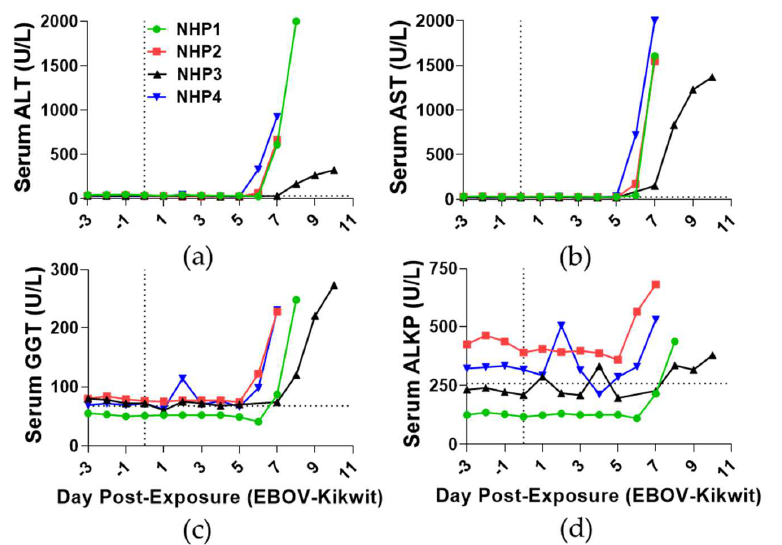
Figure 4. Time course of serum liver enzyme activity of EBOV-challenged rhesus macaques. Serum levels of ( a ) alanine aminotransferase, ( b ) aspartate aminotransferase, ( c ) gamma-glutamyl transfer- ase, and ( d ) alkaline phosphatase were detected using Piccolo chemistry. DPE 0 is marked by a black vertical dot line. The black horizontal dashed line is the average of all animals for DPE 0. Glucose concentrations notably increased on DPE 4 (109.25 ± 26.32 mg/dL; Figure S11d), and then mean endpoint concentrations (35.25 ± 19.00 mg/dL) dropped below base- line by 51%. Trends of serum calcium, amylase, total protein, and albumin decreased throughout the time course relative to baseline, except for the fluctuation observed with NHP4 on DPE 2 and NHP2 on DPE 6 (Figure S11e–h). The mean endpoint concentrations of serum calcium (30%; Figure S11e) and amylase (46%; Figure S11f) decreased below baseline. The mean endpoint concentrations of total protein (12%; Figure S11g) and albu- min (32%; Figure S11h) also decreased below baseline.